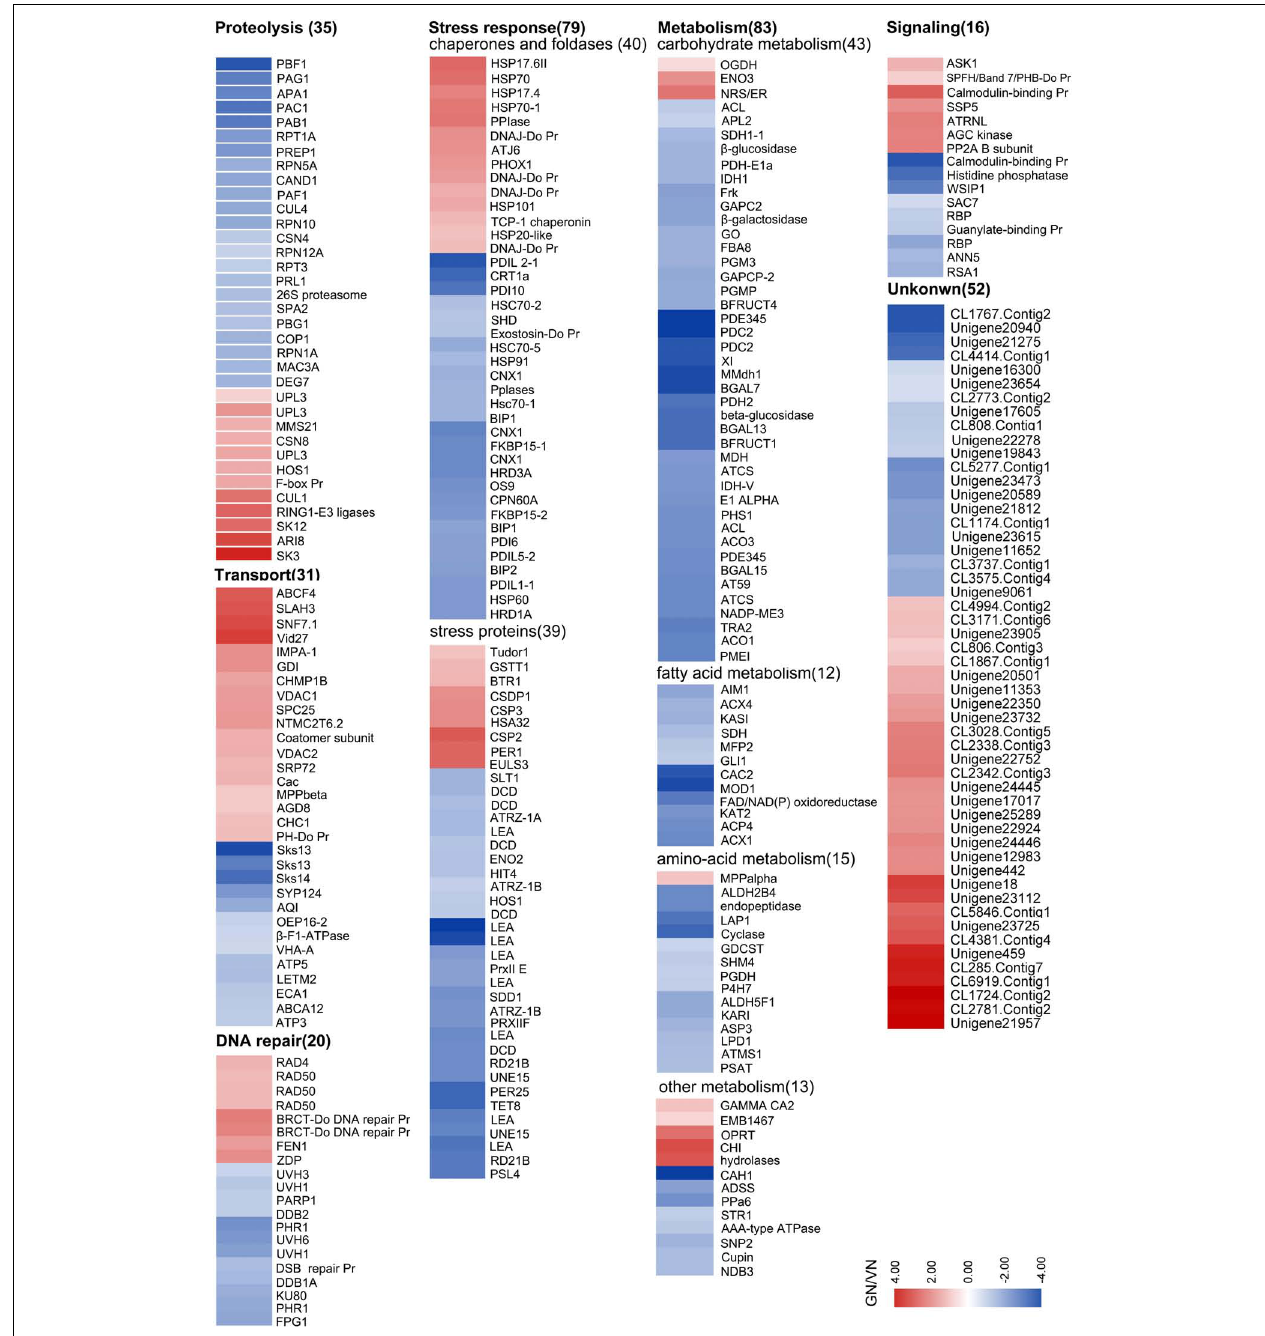
FIGURE 2 | Abundance patterns of 720 DAPs revealed from the proteomic analysis. The different “ribbons” represent various functional categories with functional annotation and protein number at the top of each “ribbon.” The rows of the “ribbon” represent individual protein, and the abbreviation for each protein and accession numbers of unknown proteins are listed on the right side (see detailed protein information in Supplementary Tables 2 , 3 ). The scale bar indicates log (base2)-relative protein abundance ratios between GN and VN. Protein highly expressed in VN or GN was indicated in red or blue,